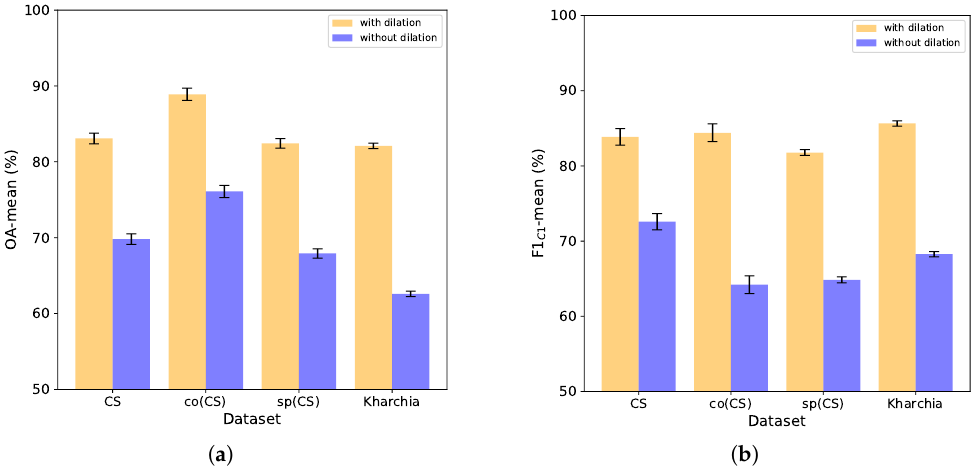
Figure 6. Performance comparison ( a ) OA-mean and ( b ) F1 C1 between dilated convolution and standard convolution in our proposed architecture. Note: the values are averaged from 5-fold